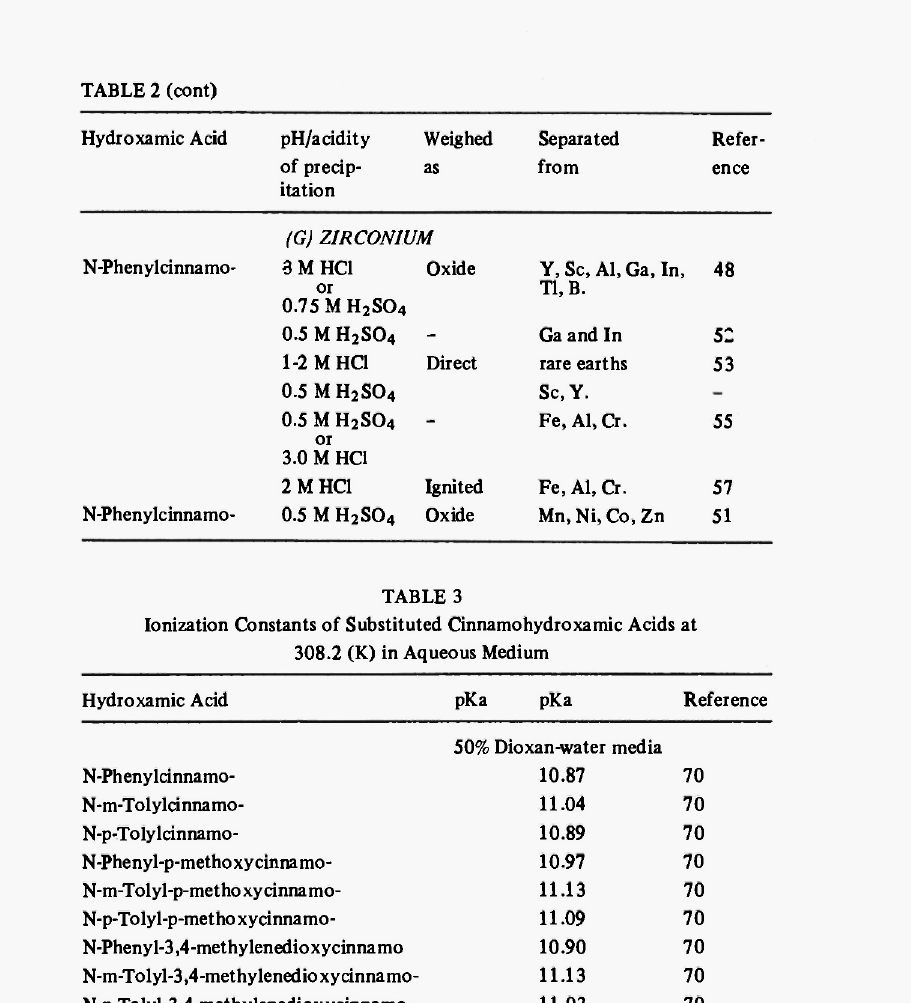
Ionization Constants of Substituted Cinnamohydroxamic Acids at 308.2 (K) in Aqueous Medium Hydroxamic